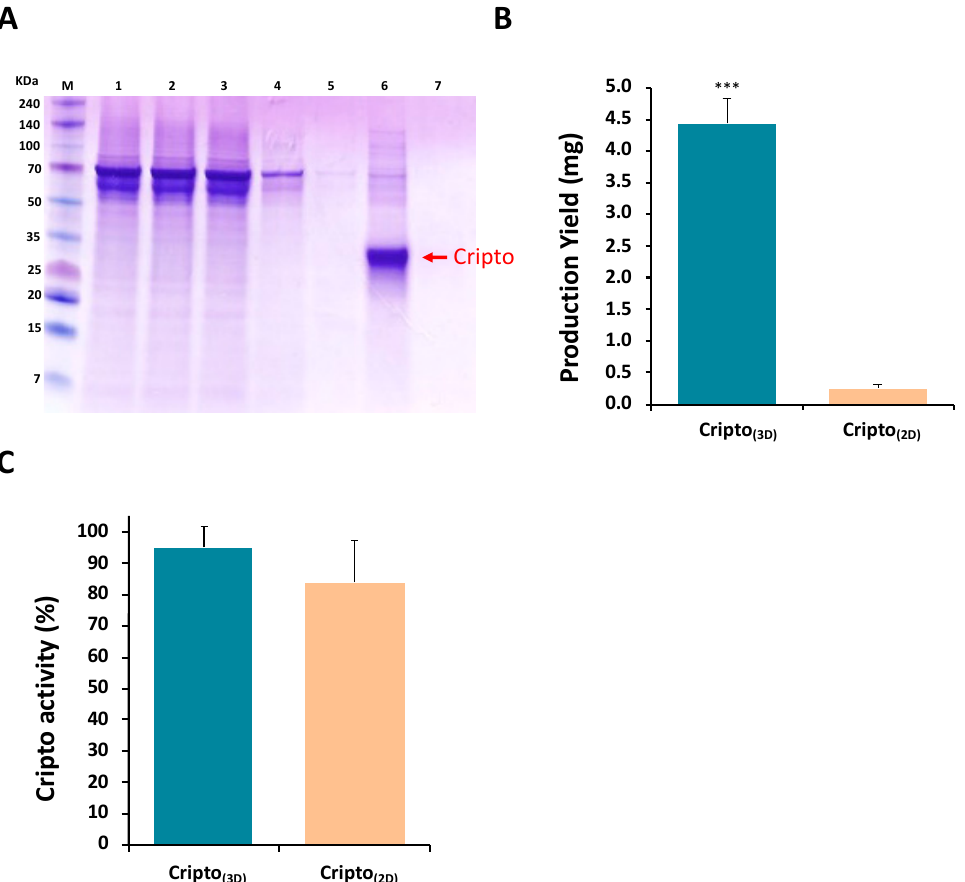
Figure 3. The production yield, activity, and puri fi cation of recombinant Cripto produced in the 3D microcarriers as compared to the 2D method. ( A ) SDS-PAGE analysis of the puri fi cation steps of recombinant Cripto: lane M is the protein molecular weight marker; lane 1 is the protein solution from ultra fi ltration; lane 2 is the fl owthrough after the fi rst passage through the His-tag a ffi nity Ni- NTA resin; lane 3 is the fl owthrough after the second passage through the same resin; lane 4 is the fi rst wash step; lane 5 is the second wash step; lane 6 is the fi rst elution from the His-tag a ffi nity Ni- NTA resin; and lane 7 is the second elution from the same resin. The band at approximately 27 kDa is the Cripto protein (indicated by the red arrow). ( B ) Quantitative amounts of Cripto protein pro- duced in the 3D batch (Cripto (3D) ) with HEK293T cells encapsulated in PF microcarriers and incu- bated in bioreactors after three rounds of harvesting are compared to the maximum amount of Cripto produced in the 2D batch (Cripto (2D) ) with HEK293 cells adherent to cell culture plates and cultured to their density threshold limits. An initial cell seeding of 3.2 × 10 6 cells was used for both techniques. ( C ) The biological activity of recombinant Cripto was compared for Cripto produced in PF microcarriers versus the 2D method by measuring binding a ffi nity to the AlK4 receptor. Four independent experiments were carried out for the 3D system and three independent experiments were performed for the 2D cultivation method. Results are shown as mean ± S.D. *** indicates p<0.001. 2.2. In Vitro Functional Activity of Puri fi ed Recombinant Cripto